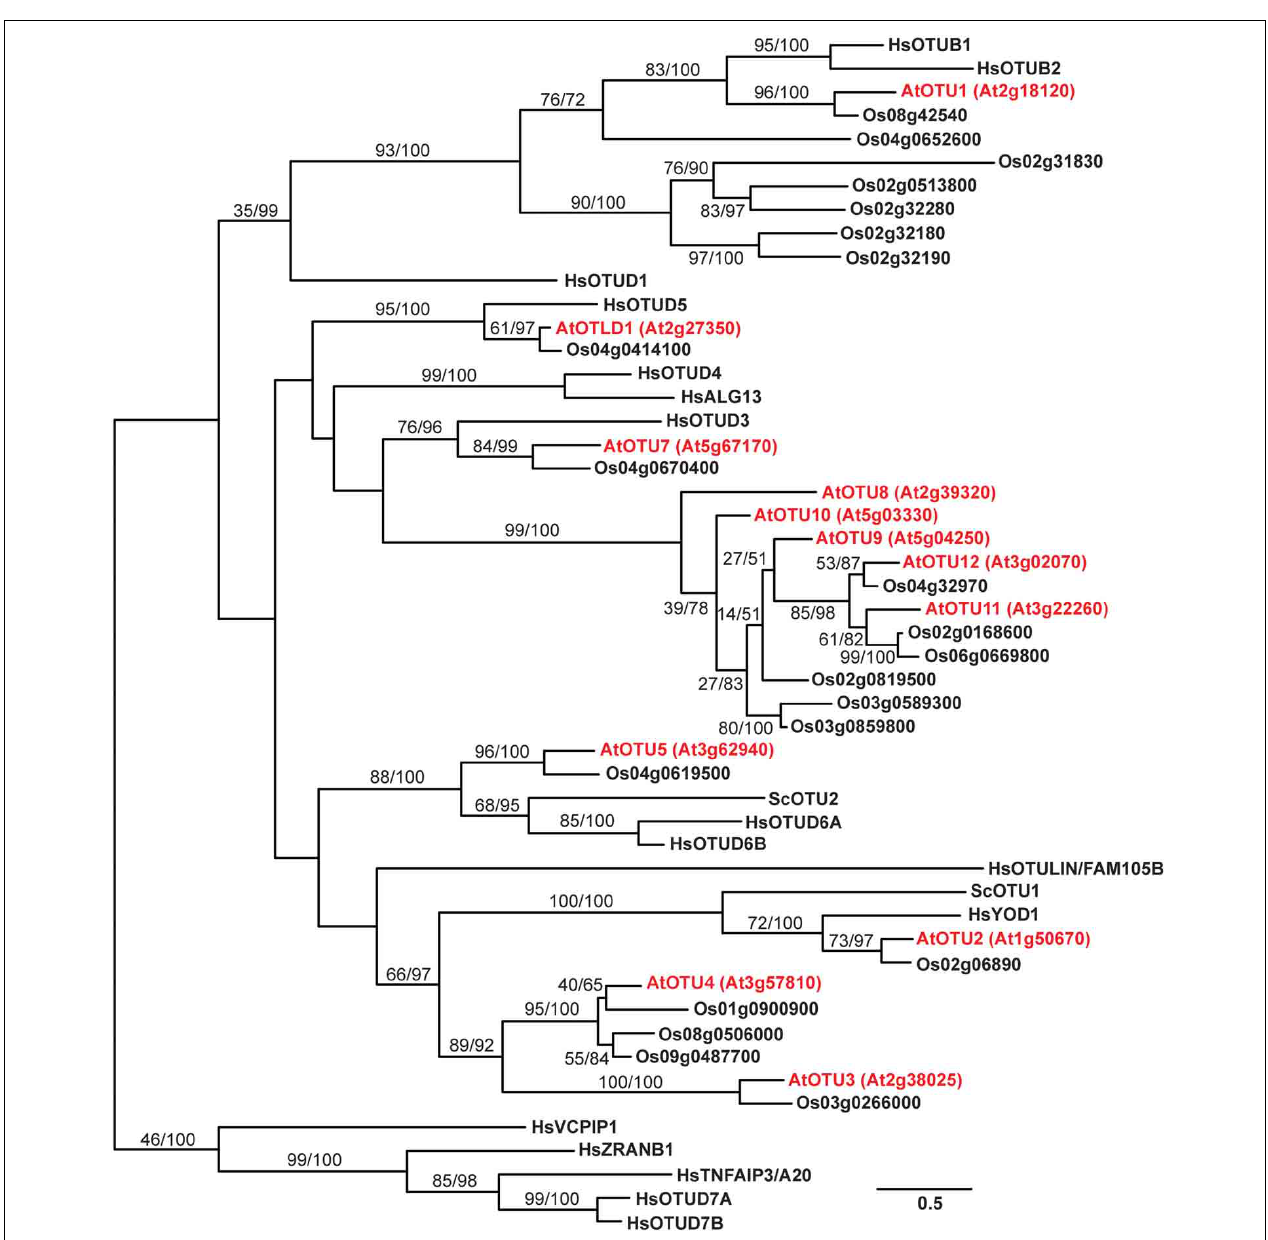
FIGURE 1 | A phylogenetic tree for the OTU proteins from A. thaliana , O. sativa , S. cerevisiae , and H. sapiens . The phylogenetic tree was generated using aligned OTU domain sequences from A. thaliana , O. sativa , H. sapiens , and S. cerevisiae . The branch labels separated by a slash indicate bootstrap support and Bayesian posterior probability. The branch length is based on the maximum likelihood results, and the scale represents the branch length that